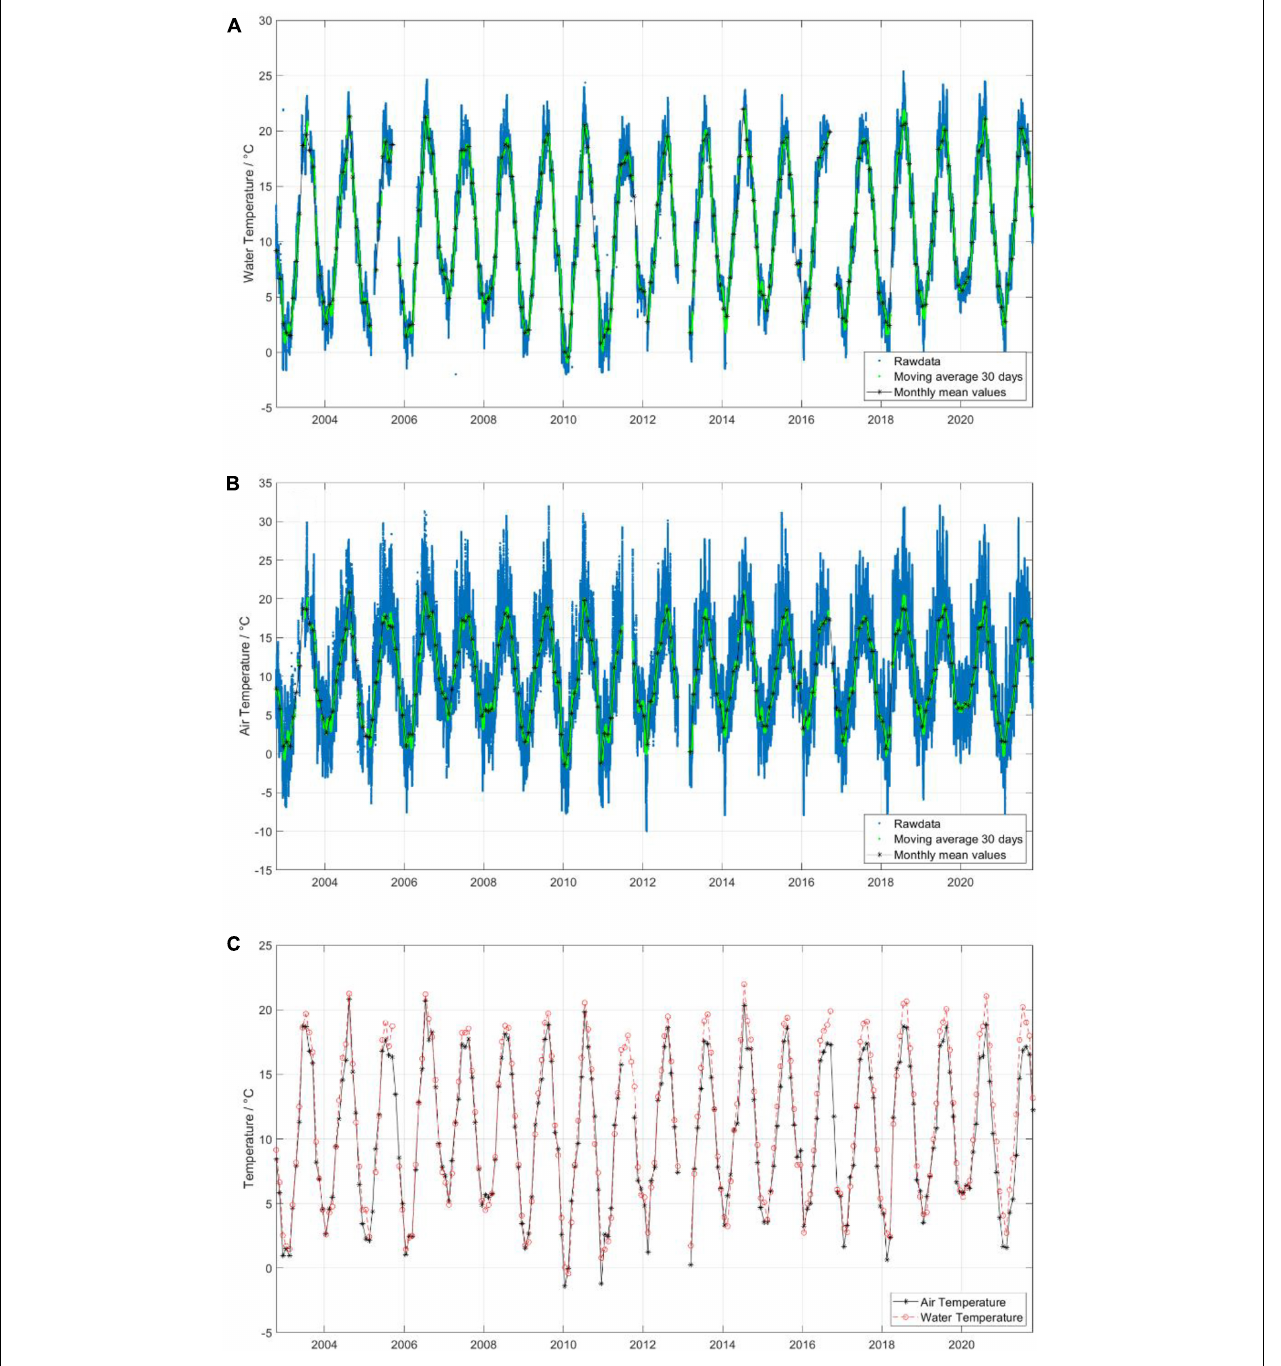
FIGURE 6 | Temperature time series measurements. Time series plots from the Time-Series Station Spiekeroog showing air and water temperature from 2002 until late 2021. (A) Displays the raw water surface temperature, measured in tube K ( Figure 5 ), a moving average of 30 days and monthly mean values. (B) Displays the raw air temperature, a moving average of 30 days and monthly mean values. (C) Shows the monthly mean values of air and water temperature.